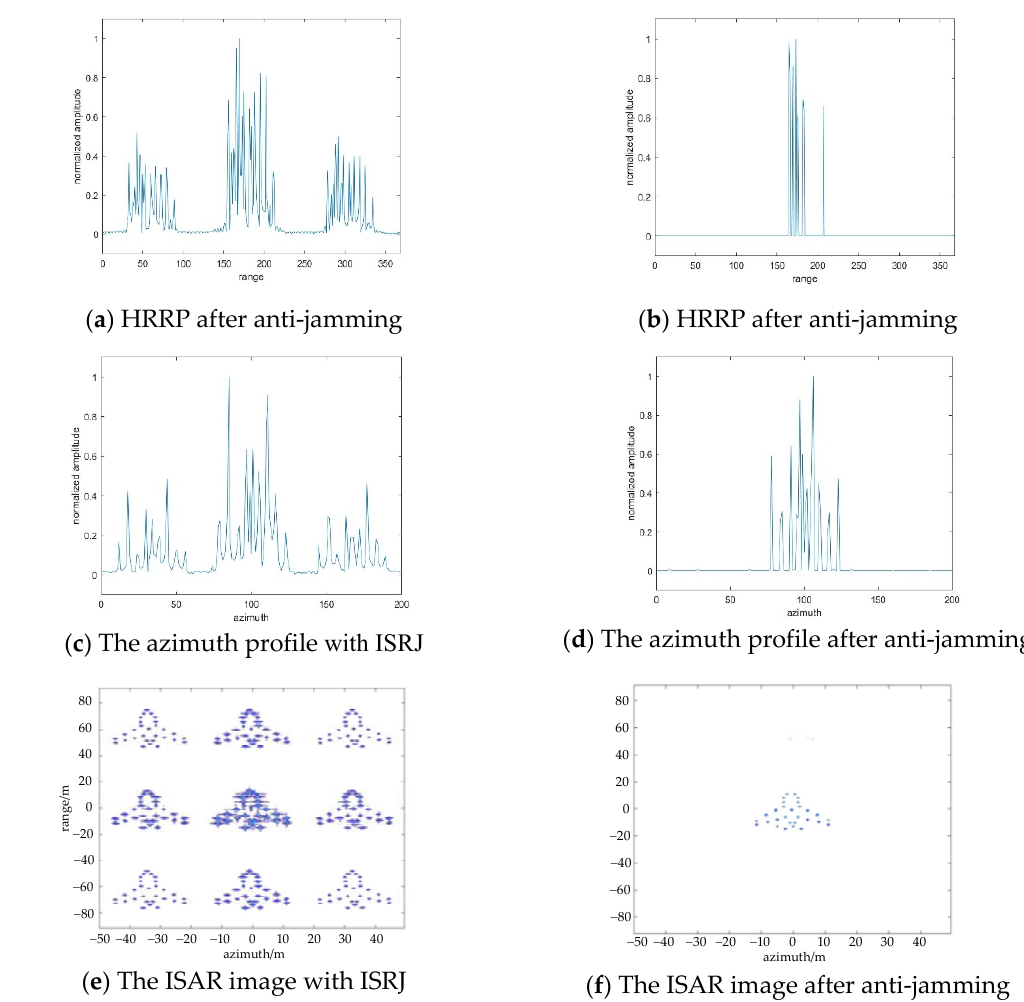
Figure 9. The results of ISRJ jamming and anti-jamming in the fast time domain, slow time domain, and ISAR image with JSR dB 40 .